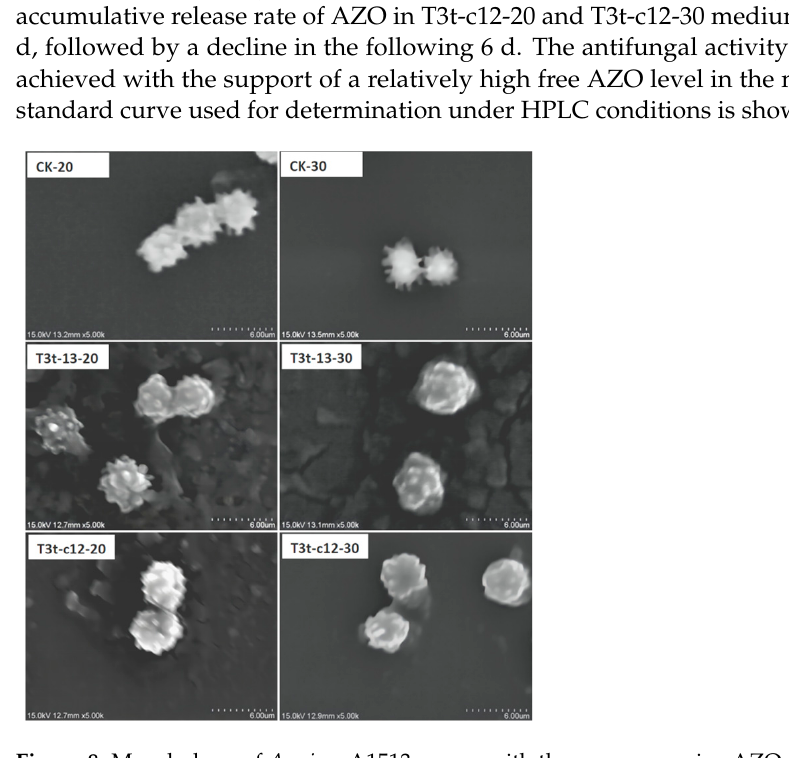
Figure 8. Morphology of A. niger A1513 spores with thermo-responsive AZO-loaded NP treatment under SEM. CK-20 and CK-30 were A. niger A1513 spores air-dried at 20 °C and 30 °C, respectively; T3t-13-20 and T3t-13-30 were A. niger spores air-dried at 20 °C and 30 °C, respectively, after co- incubation with T3t-13 NPs; T3t-c2-20 and T3t-c2-30 were A. niger spores air-dried at 20 °C and 30 °C, respectively, after co-incubation with T3t-c2 NPs.